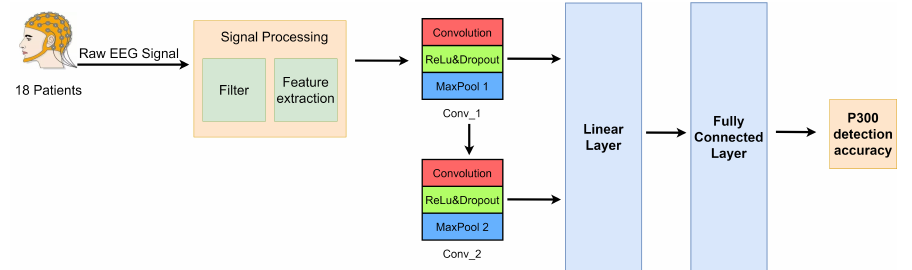
Figure 1. Conceptual diagram of CNN processing EEG